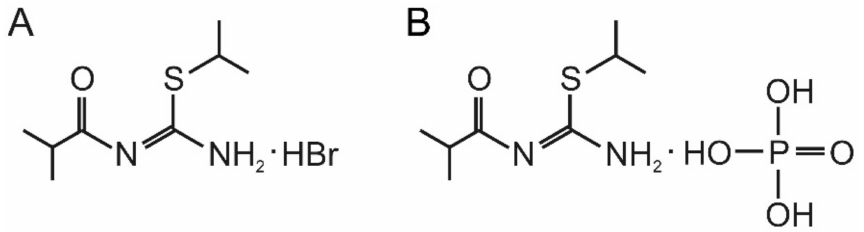
Figure 1. Structural formulas of the studied compounds. ( A ) 1-isobutanoyl-2-isopropylisothiourea hydrobromide (compound T1023); ( B ) 1-isobutanoyl-2-isopropylisothiourea phosphate (com- pound